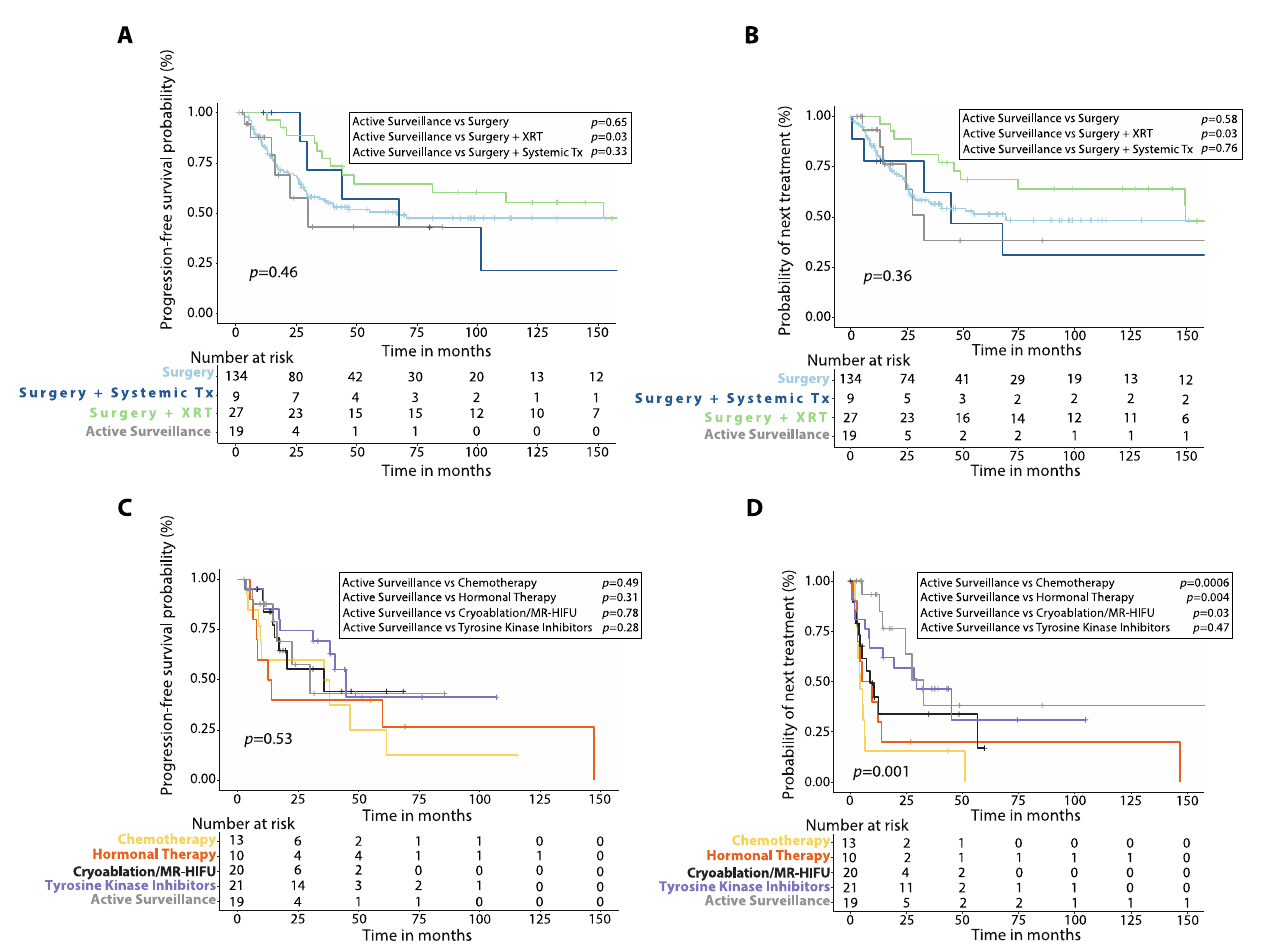
Figure 5. Progression-free survival (PFS) and time to next treatment (TTNT) after first-line therapy in patients with desmoid tumors managed with active surveillance versus other treatments. ( A ) Kaplan–Meier curve shows PFS of patients managed with active surveillance compared to those treated with upfront surgery, surgery plus adjuvant radiotherapy (XRT) or surgery plus adjuvant systemic therapy. ( B ) Kaplan–Meier curve shows TTNT after first-line therapy of patients managed with active surveillance compared to those treated with upfront surgery, surgery plus adjuvant radiotherapy (XRT) or surgery plus adjuvant systemic therapy. ( C ) Kaplan–Meier curve shows PFS of patients managed with active surveillance compared to those treated with first-line chemotherapy, hormonal therapy, cryoablation/MR-HIFU or tyrosine kinase inhibitors (TKIs). ( D ) Kaplan–Meier curve shows TTNT after first-line therapy of patients managed with active surveillance compared to those treated with first-line chemotherapy, hormonal therapy, cryoablation/MR-HIFU or TKIs. p -values were calculated with the Log-Rank method. XRT: radiotherapy; Systemic Tx: Systemic therapy; Surgery plus systemic therapy includes surgery plus adjuvant chemotherapy, surgery plus adjuvant hormonal therapy, surgery plus imatinib; MR-HIFU: Magnetic resonance-guided high intensity focused